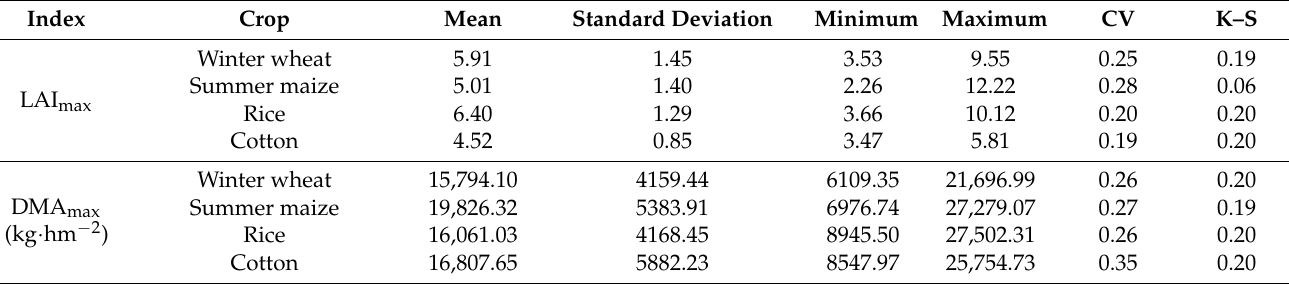
Figure 10. Spatial distribution of maximum dry-matter accumulation (DMA max ) for ( A ) winter wheat, ( B ) summer maize, ( C ) rice, and ( D ) cotton. Table 14. Statistics for the Spatial Variability of the Indices of Crop Growth. CV, Coefficient Of Variation; K–S, Results of the K–S Test.